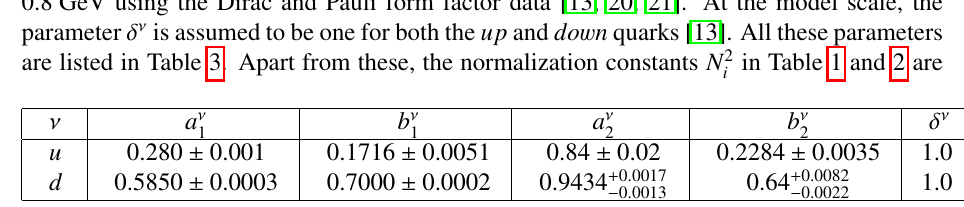
Table 3: Values of model parameters corresponding to up and do w n quarks appearing in Eq. (3).